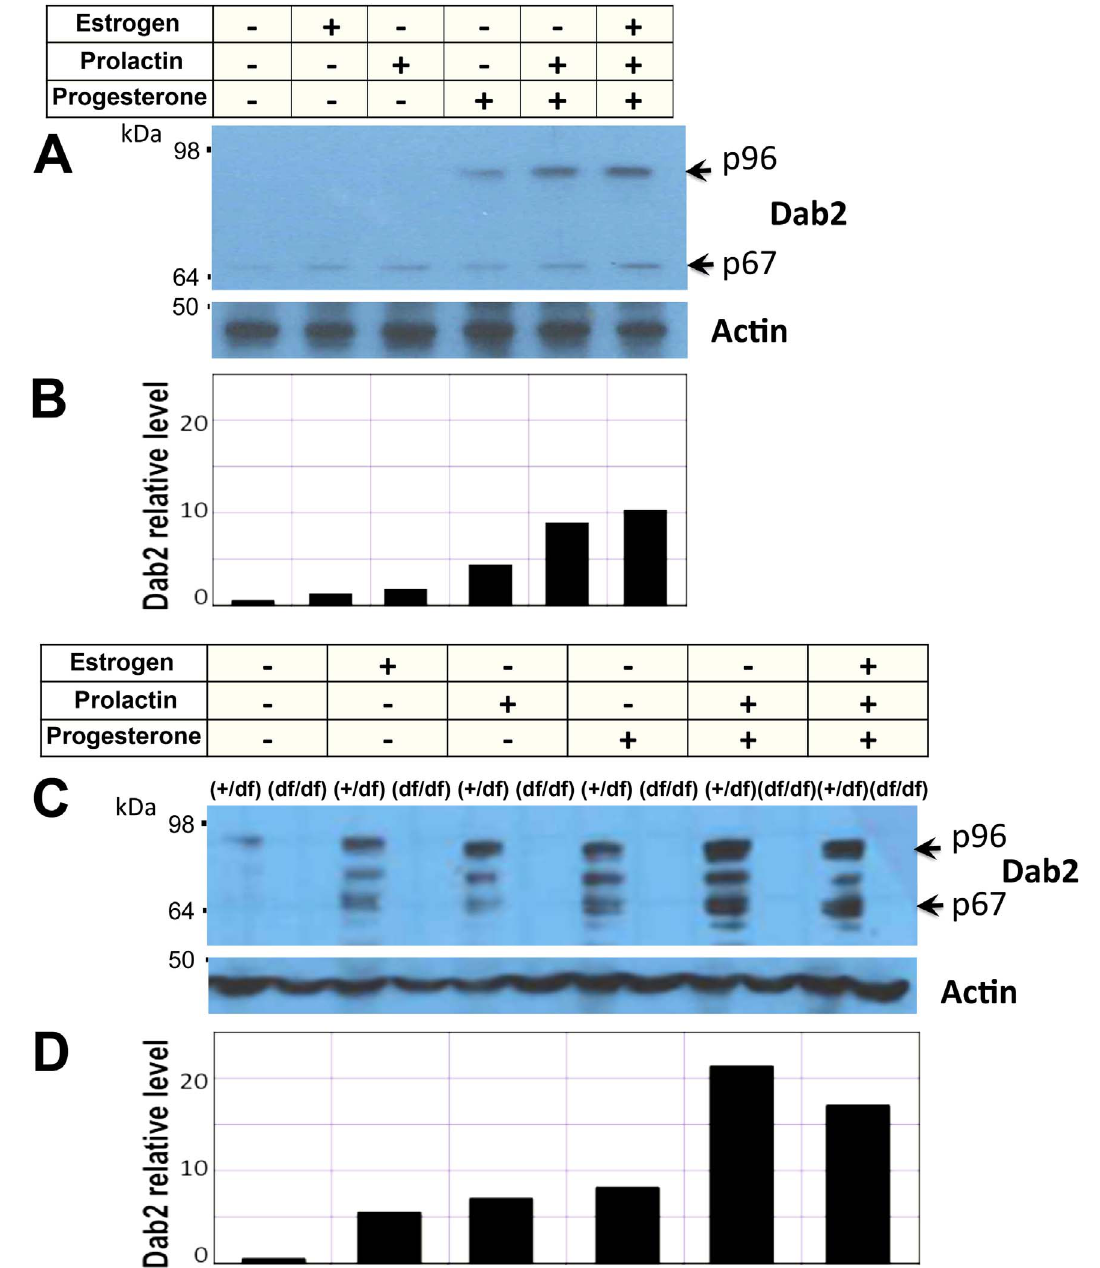
Figure 2. Hormonal induction of Dab2 expression in primary mammary epithelial cells. Mammary epithelial cells were prepared from virgin wildtype control (fl/ + ) and Dab2 conditional knockout (df/df) mice inheriting Meox2-Cre. The cells were treated with 17 beta estradiol (1 nM), progesterone (1 m M), and prolactin (1 nM, or 50 ng/ml), individually or in combination for 4 days in culture. ( A ) Dab2 and beta-actin from primary mammary epithelial cells of virgin mice were analyzed by Western blot. ( B ) The signals of Dab2 proteins from the Western blot were quantified using NIH Image J software using beta-actin as normalization control. Relative values were plotted with the value of untreated cells defined as 1.0. ( C ) Dab2 and beta-actin from primary mammary epithelial cells isolated from pregnant mice were analyzed by Western blot. Dab2 protein was absent in cells from the conditional knockout mice. ( D ) The relative intensity of Dab2 proteins on Western blots was quantified using NIH Image J software, using beta-actin for normalization.